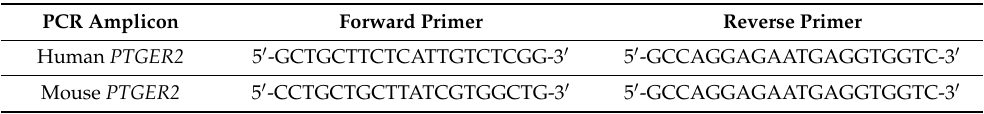
Table 4. Primer sequences for PTGER2 .